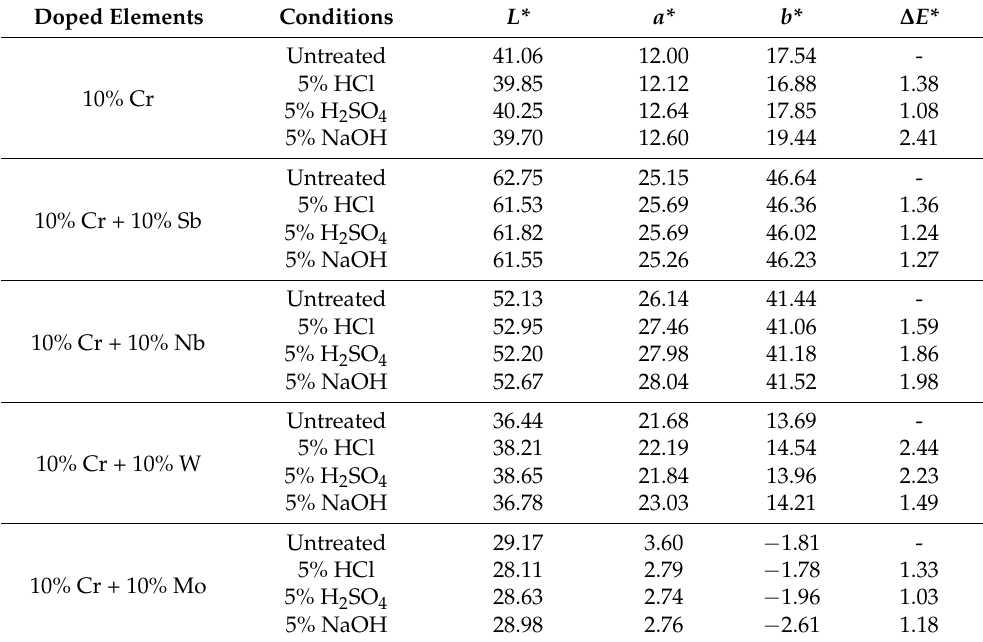
Table 3. Comparison of chromatic parameters for the Cr-doped TiO 2 pigments with and without counterions before and after the acid and alkali corrosion tests.